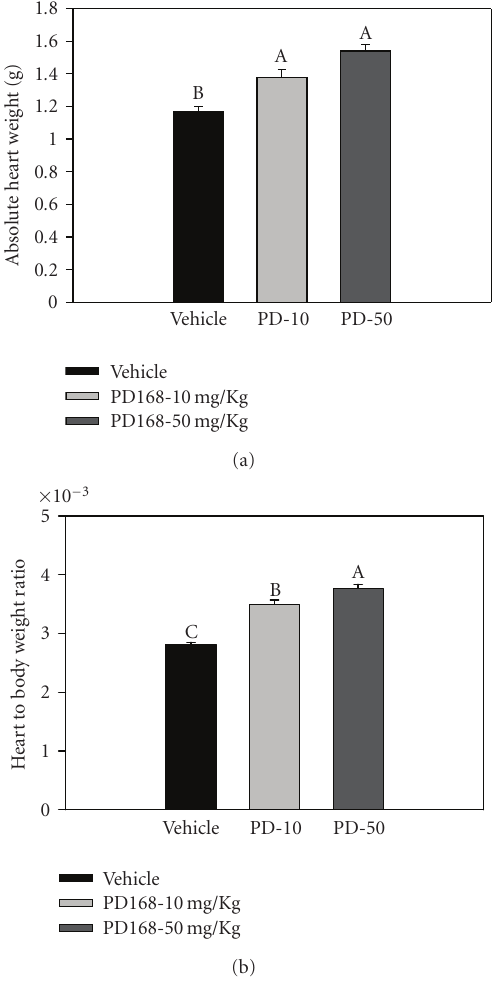
Figure 5: Cardiac hypertrophy in PD168 rats (a) absolute heart weight and (b) heart-to-body-weight ratio in normal male SD rats chronically treated with PD168 at the dose of 10 mg/kg · body weight (PD-10) or 50 mg/kg · body weight (PD-50) relative to vehicle (VEH), ( n = 10/treatment group). Means were compared using one-way ANOVA followed by Holm-Sidak test. Data are represented as means ± SEM. Di ff erent letters represent significant di ff erences between the groups with “A” being highest mean and so forth ( p < 0 . 05 was considered